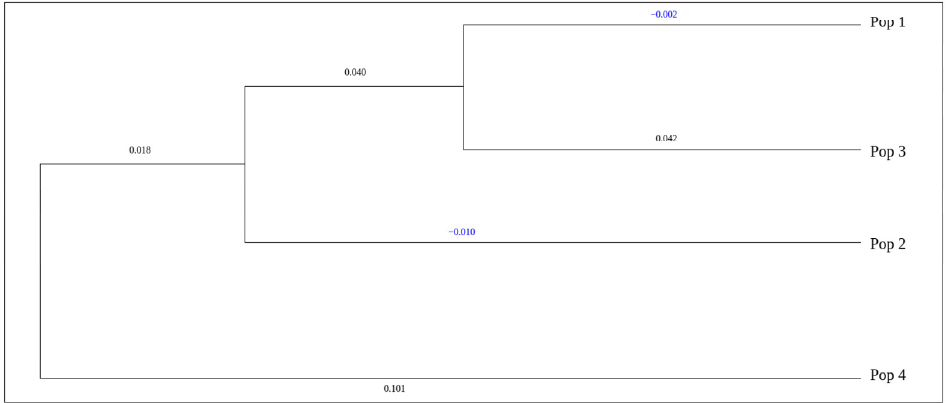
Figure 2. Phylogenetic tree based on the standard Nei’s genetic distance between four camel populations.